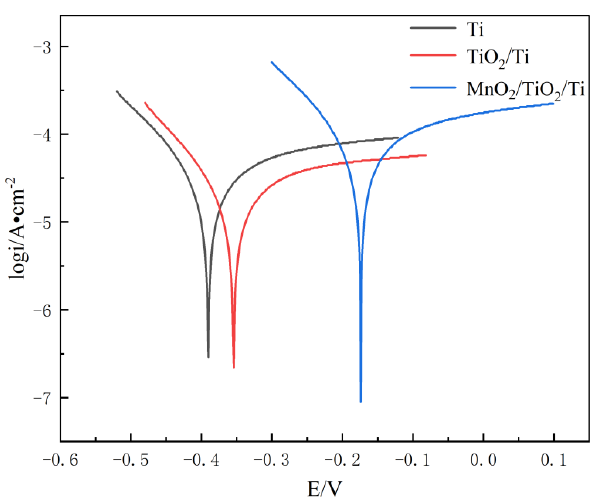
Table 1. Results of the Tafel texts of the porous Ti, surface-modified TiO 2 /Ti, and MnO 2 /TiO 2 /Ti nano composites.